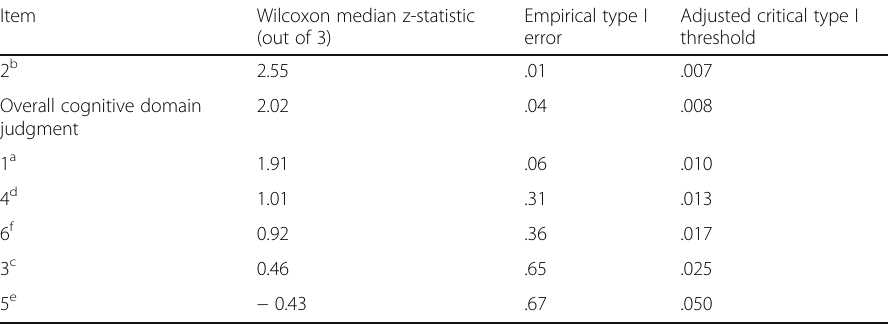
Table 5 Wilcoxon two-sample test results (Holms-Bonferroni adjusted) for each of the six quality metrics and the overall cognitive domain judgment